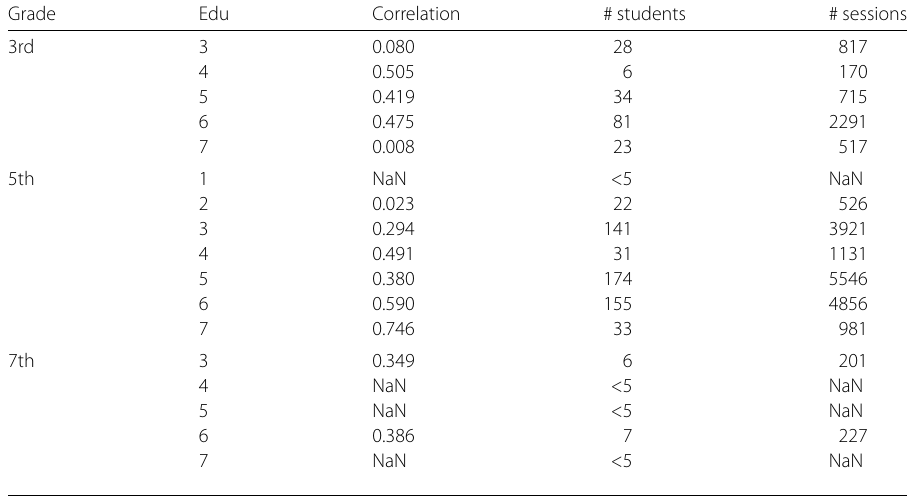
(b) By grade with the outlier